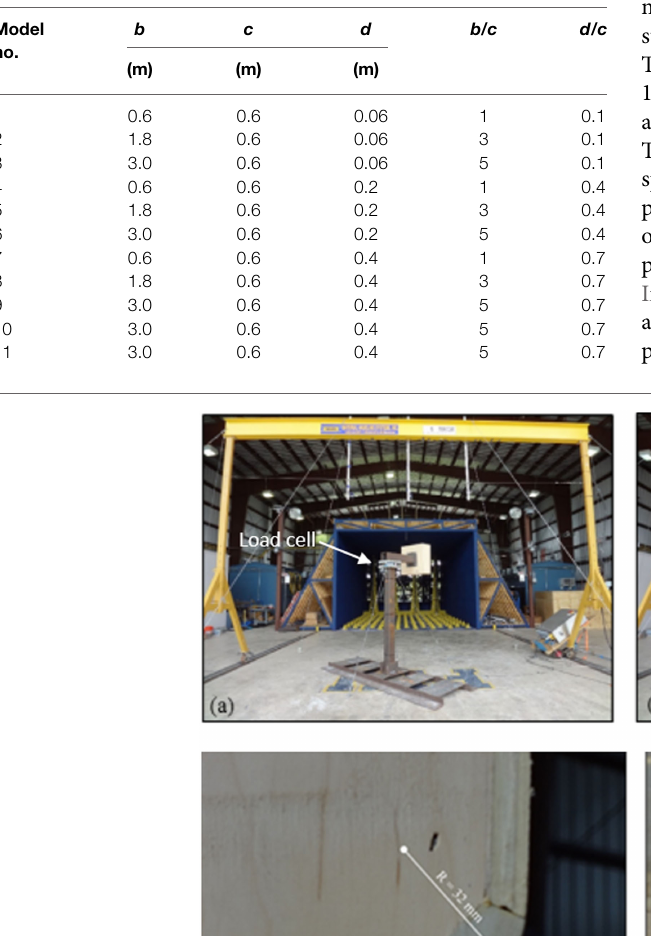
TABLE 1 | Model dimensions and geometric ratios.